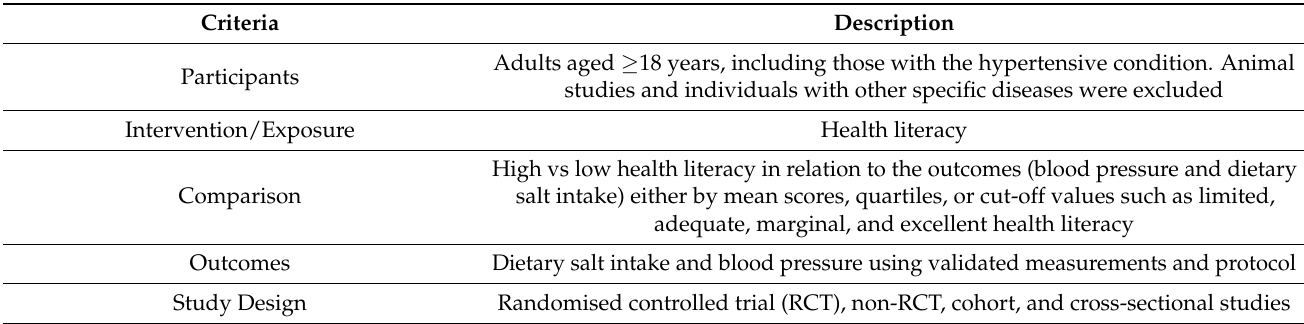
Table 1. The PICOS criteria used to construct the systematic